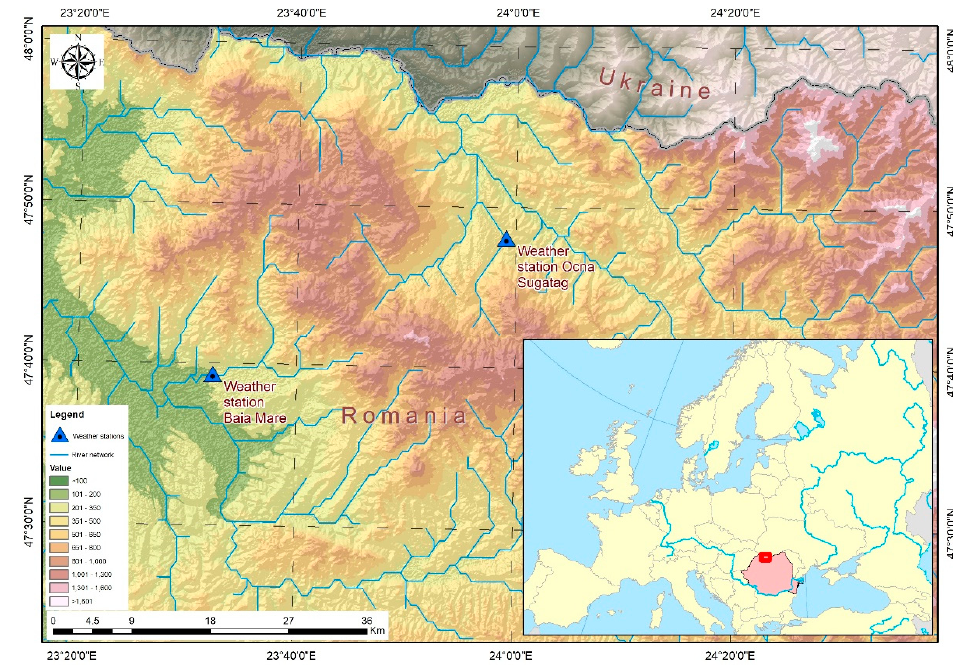
Figure 1. Location of the meteorological stations considered. Table 1. The geographical coordinates of the meteorological